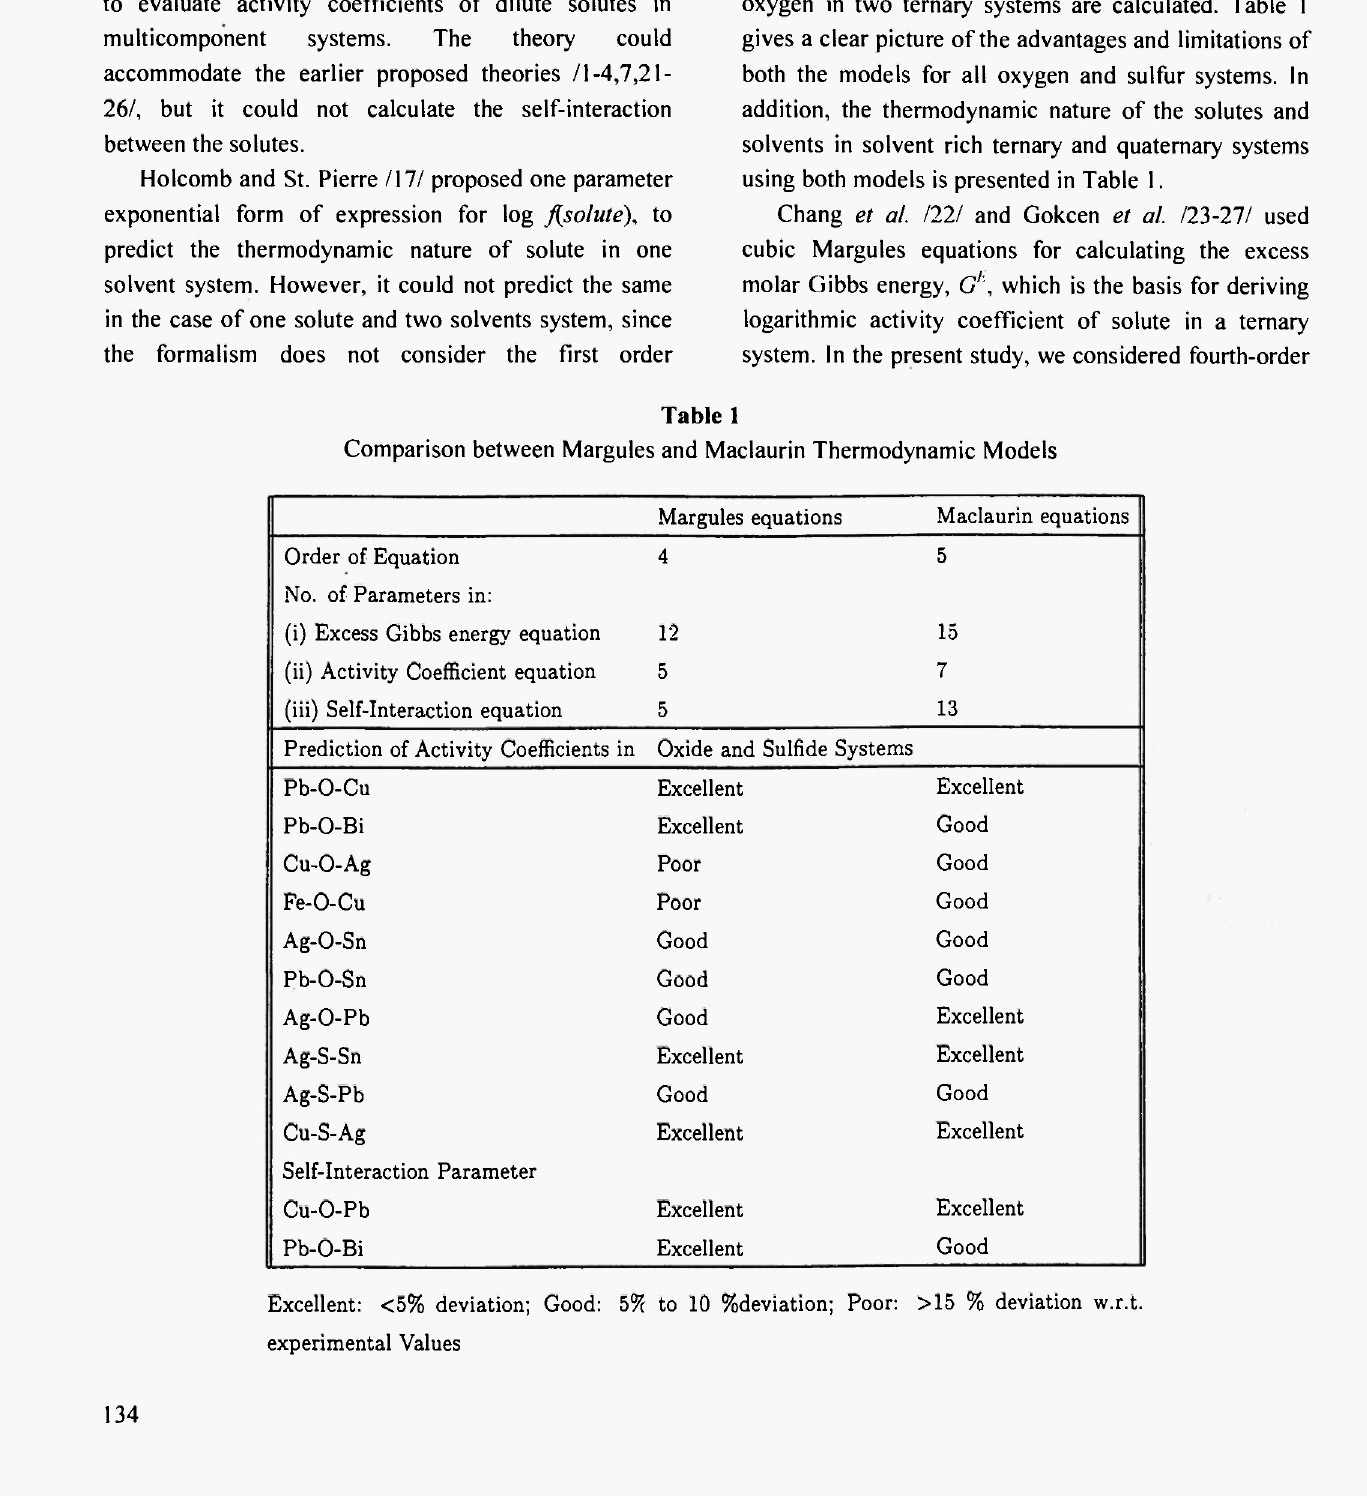
Comparison between Margules and Maclaurin Thermodynamic Models Margules